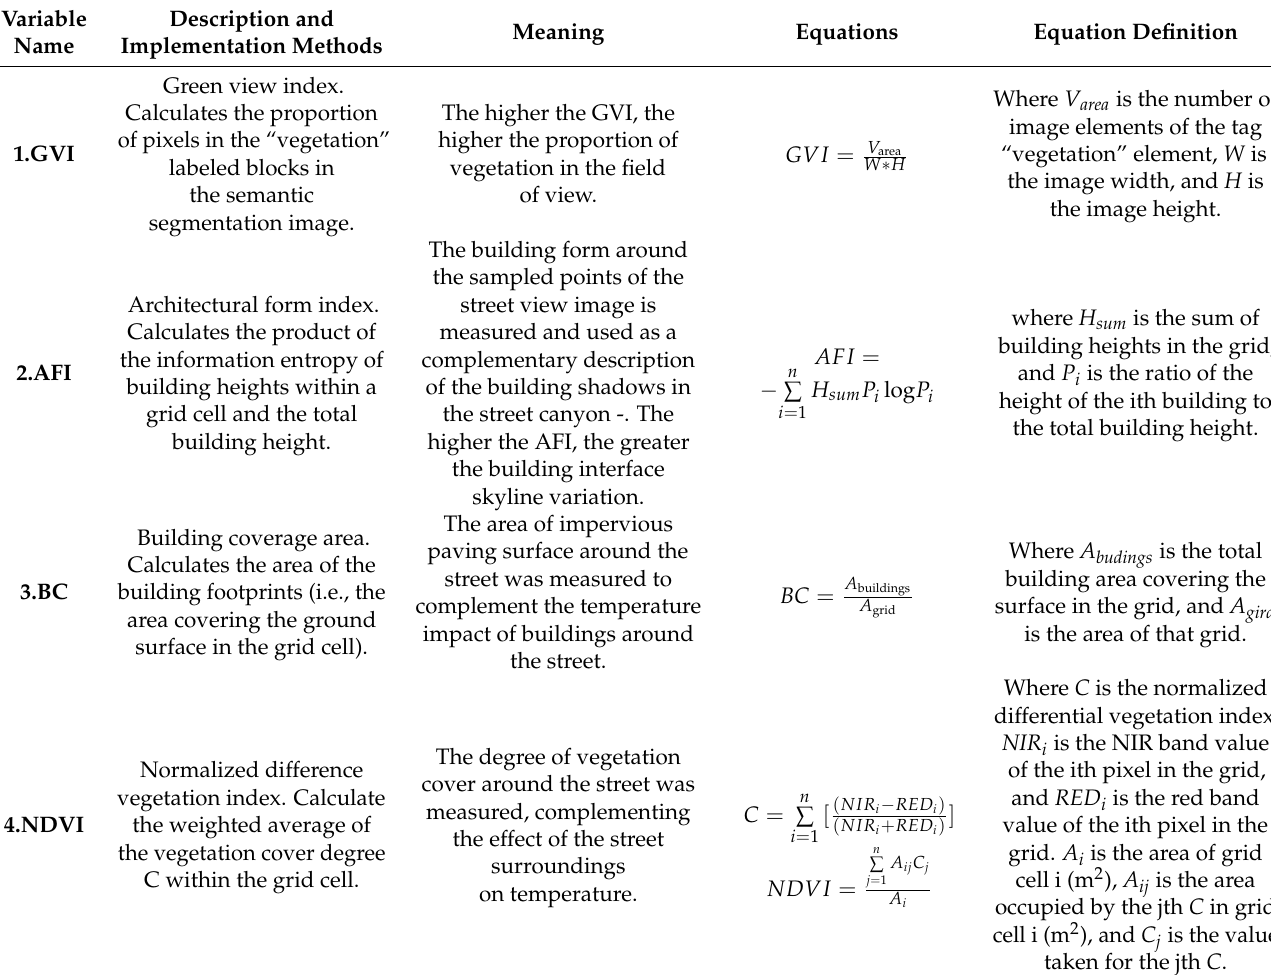
Table 2. Definitions and equations of peripheral surrounding built environment